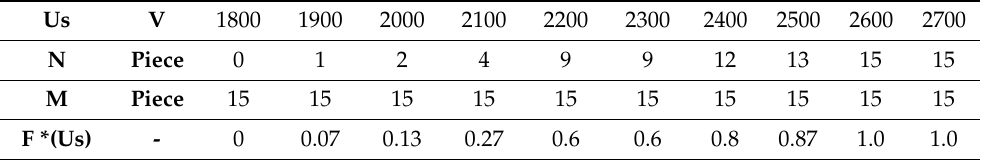
Table 2. Results of the sensitivity test of lamp A on surge impulse 1.2/50 µ s (Us—surge level; N—number of damaged lamps in batch M; M—the number of lamps in the batch; F *(Us)—cumulative empirical distribution function of damage intensity dependent on the surge level).